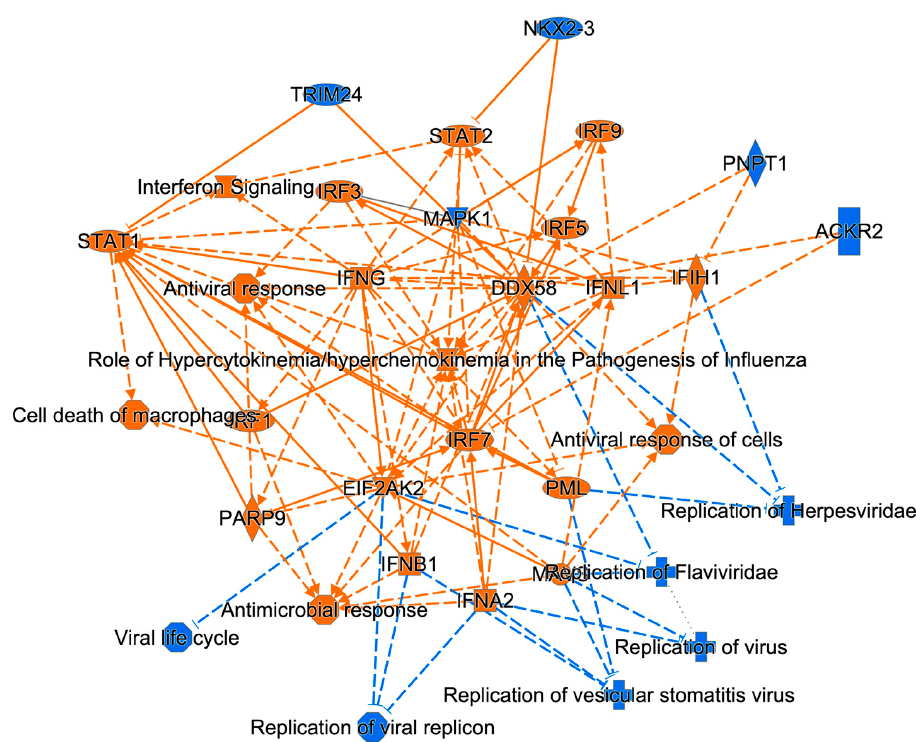
Figure 1. Ingenuity Pathway Analysis (IPA)-generated graphical summary of ZIKV-dysregulated patterns of U251 proteins and cellular functions based on the list of statistically significantly dysregulated proteins in U251 cells at 48 hours post ZIKV infection (hpi). The organization and functional linkages result from IPA default settings and using protein fold-change cut-off values of >1.33 and < − 1.33 when comparing ZIKV-infected protein abundances to time-matched non-infected protein abundances. Orange: predicted activation (as generated by IPA) Blue: predicted inhibition. Alpha value is 0.05. Statistical significance was determined using 2-tailed Students t -test and Z-score